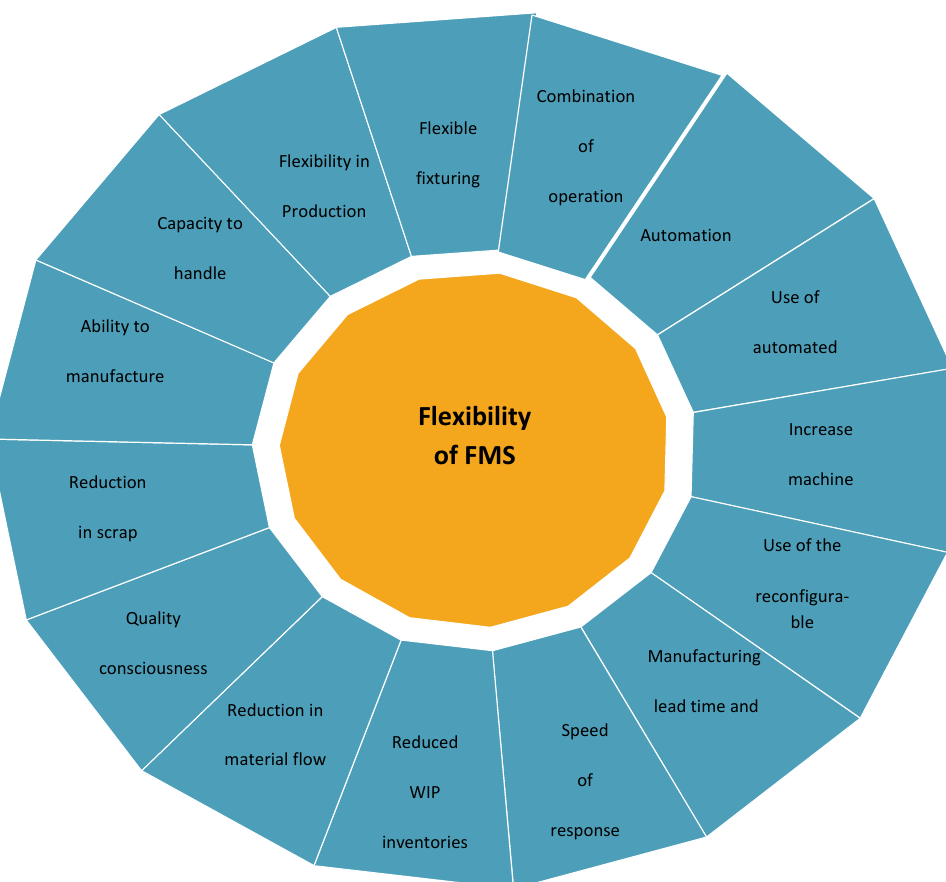
Fig. 2. Variables which effect the flexibility of